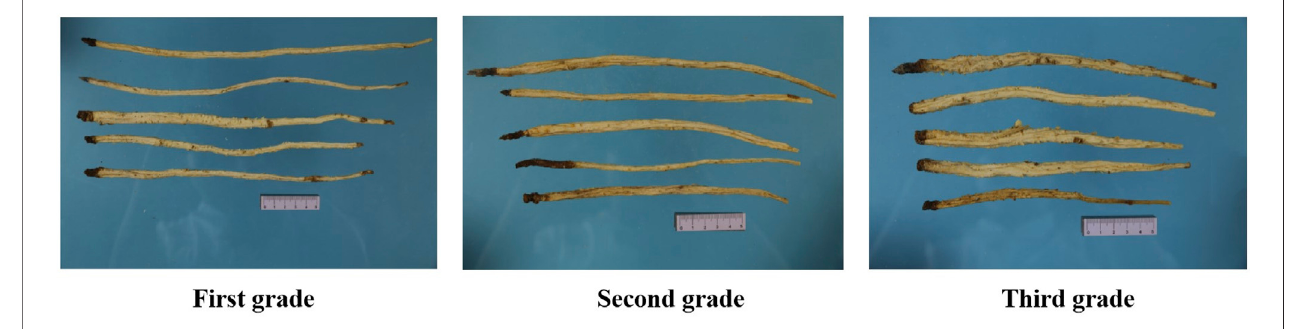
FIGURE 4 | The speci fi cation and grade of GR.